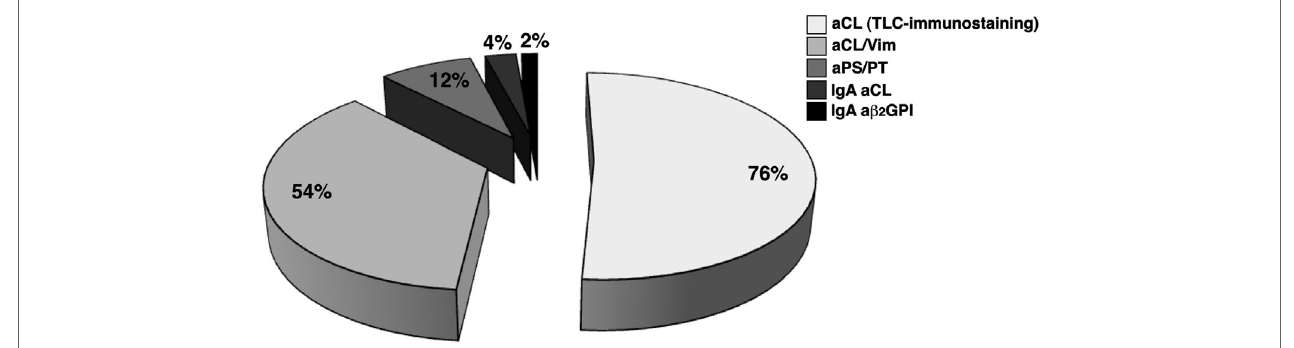
FigUre 1 | The prevalence of autoantibodies in obstetrical seronegative anti-phospholipid syndrome patients. Fifty out of 61 patients (82%) were positive for at least one of the tests used. Thirty-eight out of 50 patients (76%) showed the presence of anti-cardiolipin (aCL) antibodies detected by thin-layer